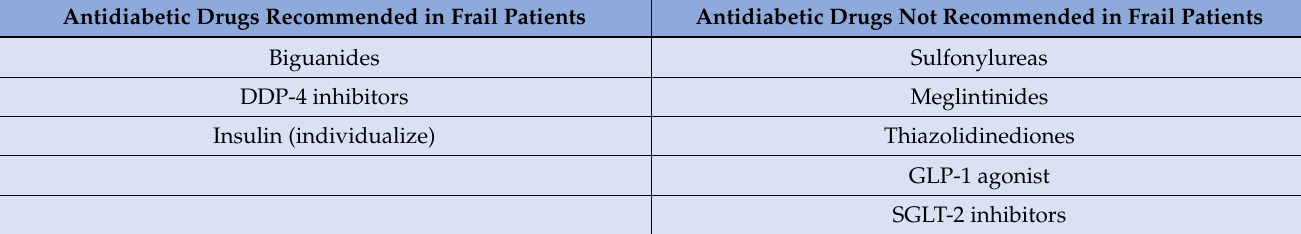
Table 4. Main recommendation drugs in T2DM patients with frailty and/or sarcopenia. Antidiabetic Drugs Recommended in Frail